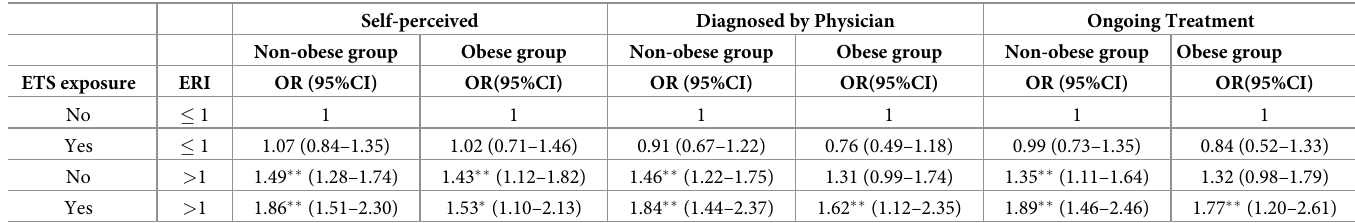
Table 5. Sensitivity analysis for evaluating the synergistic effects of exposure to ETS and ERI on risks of hyperlipidemia based on three types of